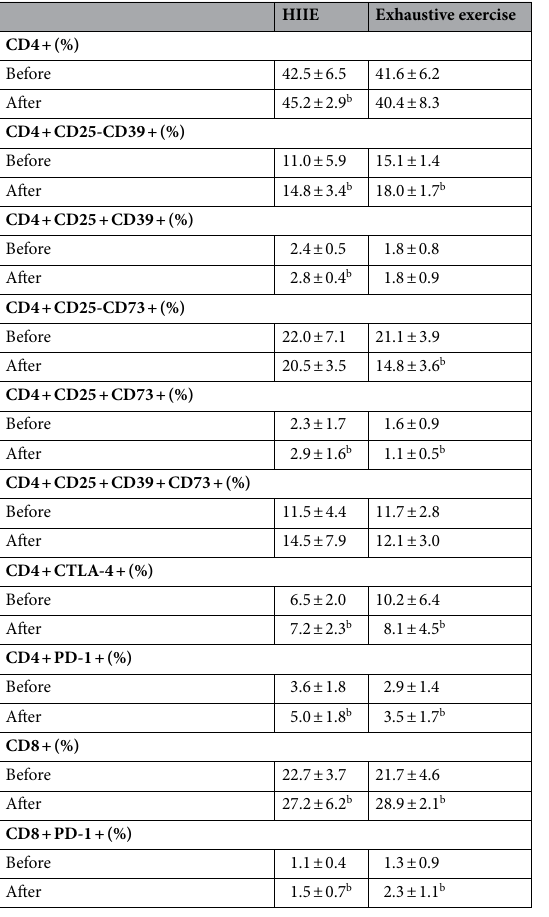
Table 2. The effect of HIIE and exhaustive exercise in peripheral frequency of T cells before and immediately after exercise. Data presented as mean ± standard deviation. a Denotes statistical difference compared to before exercise ( p < 0.05). b Denotes statistical difference compared to before exercise ( p < 0.05).